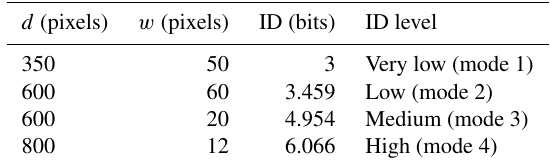
Table 1. Index of difficulty design (the range of ID is recommended by ISO).